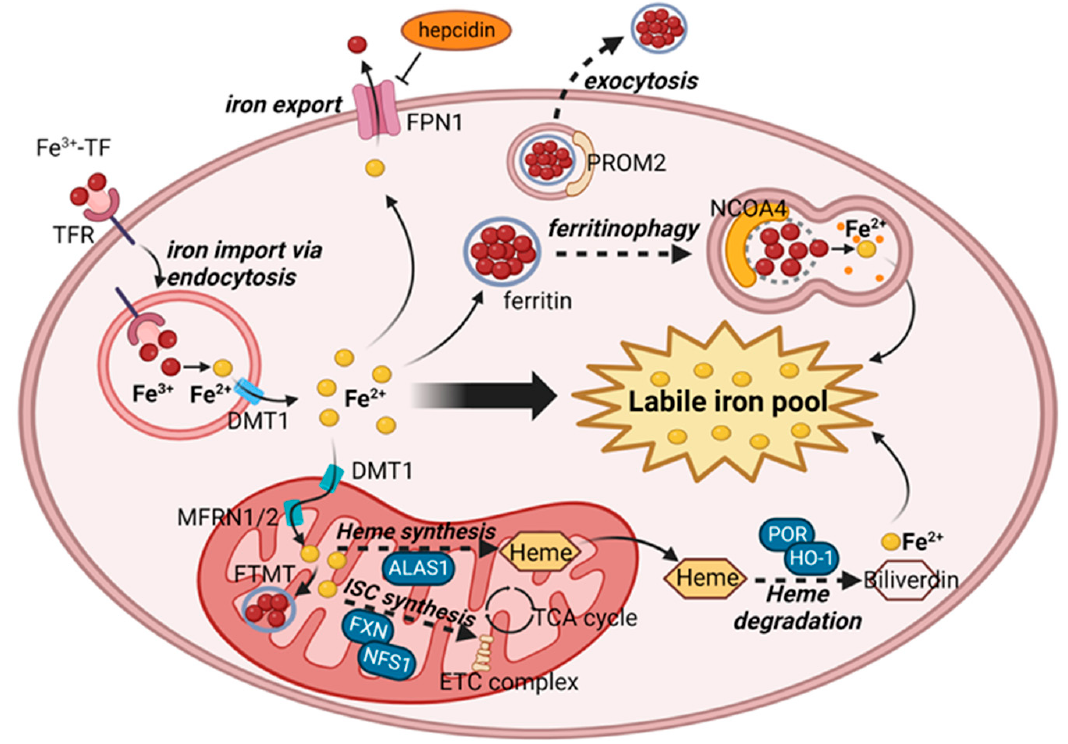
Figure 2. Cellular sources of labile iron pool. The level of a labile iron pool is regulated by iron import and export, storage by ferritin and its degradation (ferritinophagy), and synthesis and degradation of iron-containing proteins (heme and iron-sulfur cluster proteins). Abbreviations—ISC, iron-sulfur cluster; ETC, electron transport chain. The image was created with BioRender (BioRen- der.com).